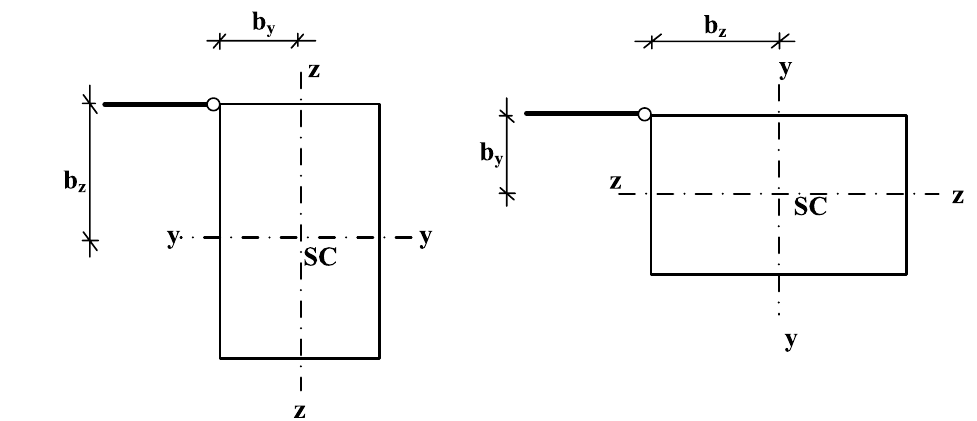
Fig. 1 Cross-section of beam supported by lateral restraints. SC is the shear centre. For doubly symmetric sections, SC coincides with the